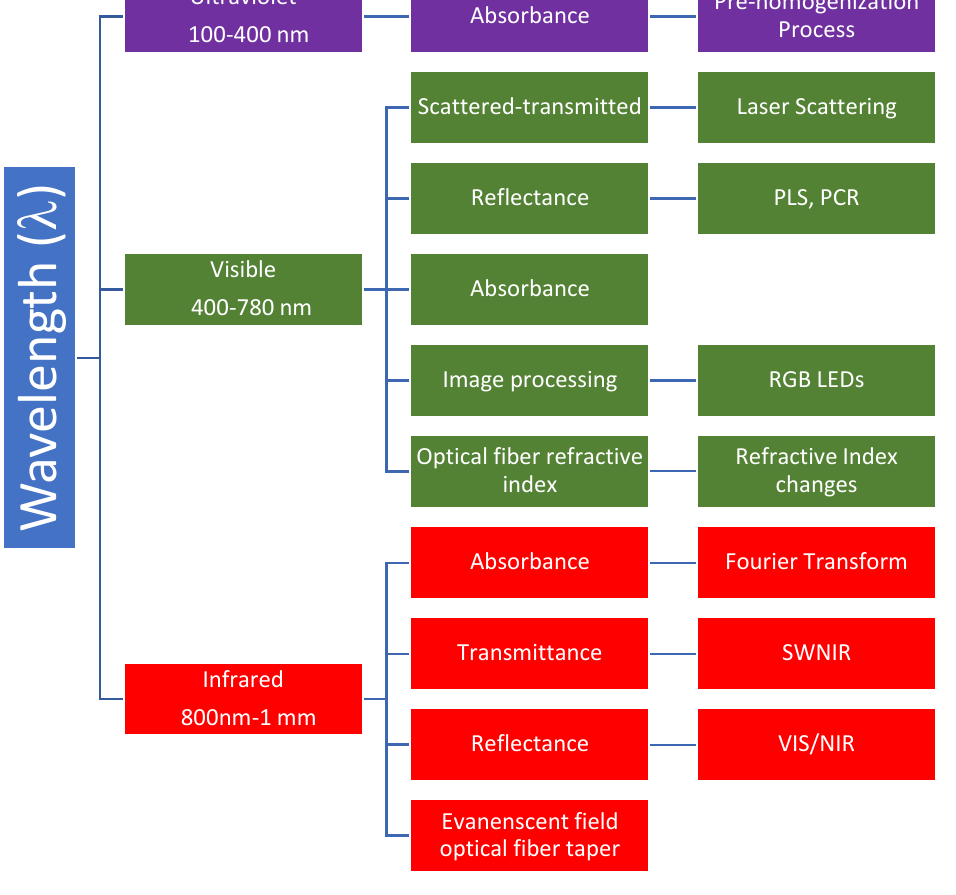
Figure 2. The techniques reported in the literature review by the wavelength operation.